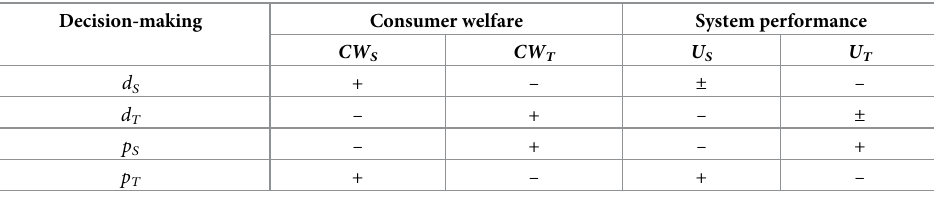
Table 3. The correlations between C W i , U i and d i , p i